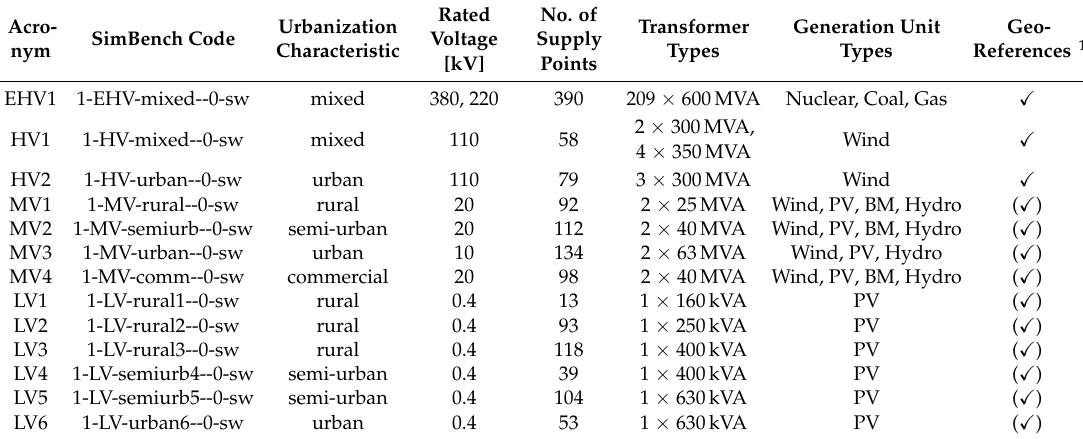
Table 1. Overview of the SimBench grids of scenario 0 with complete switch